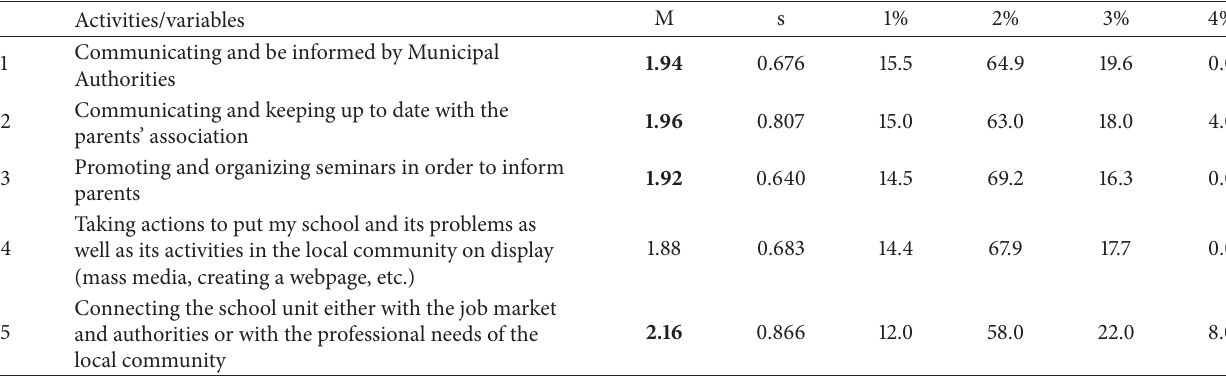
Table 5: The significance of activities regarding the relations of their school units with parents, external authorities, and the local community.